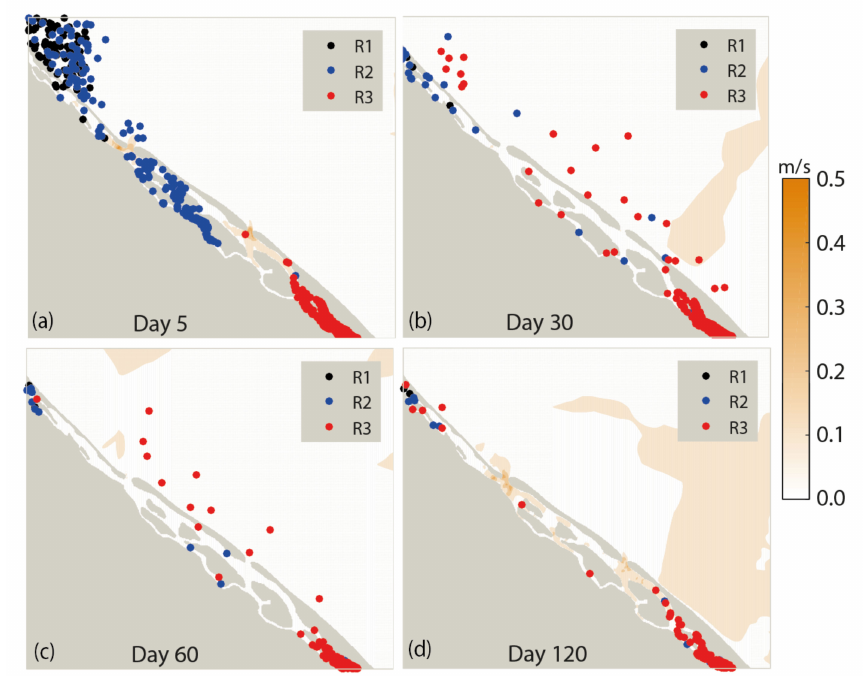
Figure 7. Spatial distributions of the current speed and trajectories for particles released at R1, R2 and R3 (please refer Figure 2 for initial release locations) on ( a ) Day 5, ( b ) Day 30, ( c ) Day 60 and ( d ) Day 120 during the southwest monsoon for both inlets